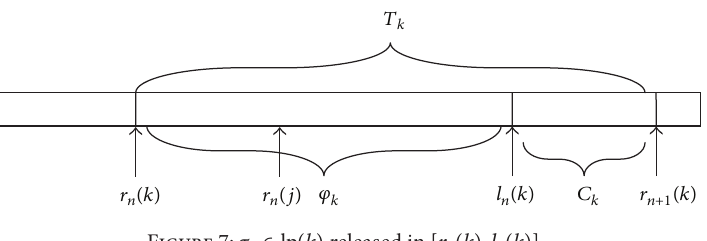
Figure 7: 𝜏 𝑗 ∈ lp (𝑘) released in [𝑟 𝑛 (𝑘),𝑙 𝑛 (𝑘)] .